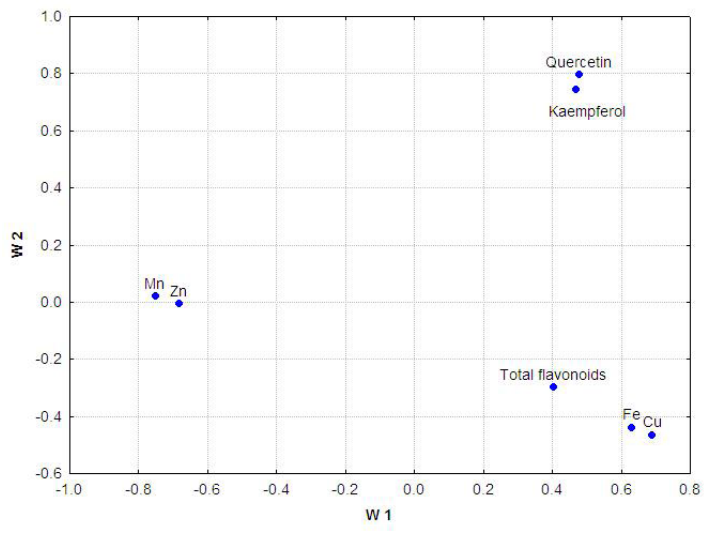
Figure 5: Loading plot of PC1 vs PC2 for the studied herbal infusions